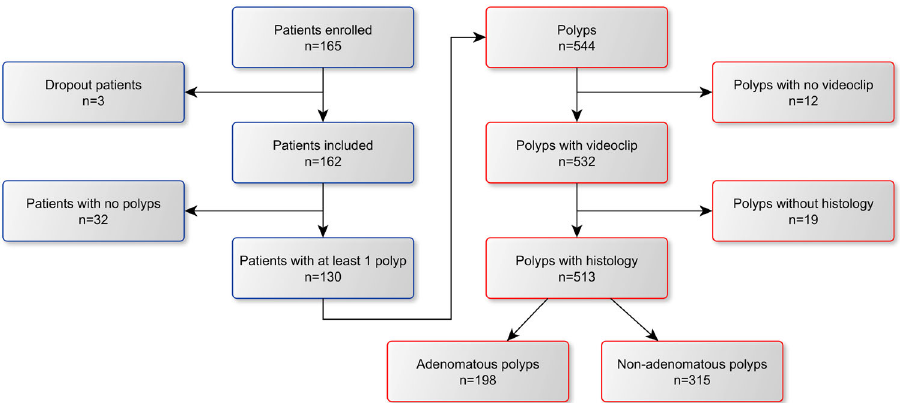
Fig. 5 Colonoscopy videos of 165 patients screened in the CHANGE study were considered for the Standalone CADx study. A total of 544 polyps videoclips from 130 patients was obtained after discarding dropout patients and patients with no polyps. This number was further reduced to 513 polyp videoclips (198 adenomas, 315 non-adenomas) after polyps with no recorded histology or missing videoclips were discarded by scienti fi c annotation